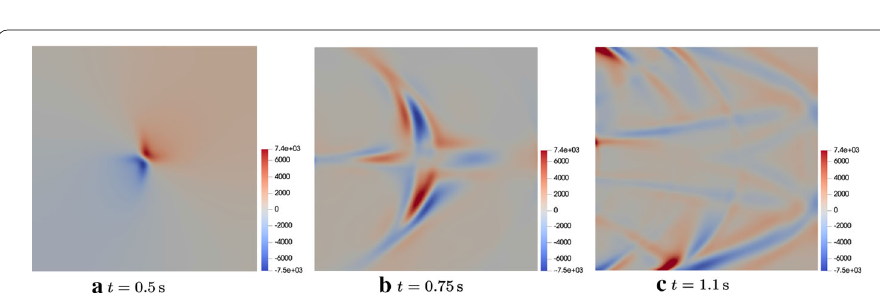
Fig. 11 Elastic wave propagation in a heterogeneous transversely isotropic medium (absolute value of the displacement field)